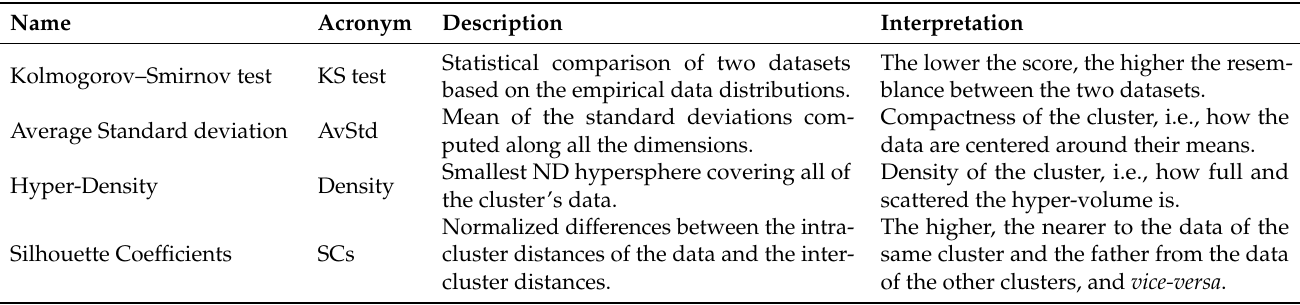
Table 1. Recapitulation of the